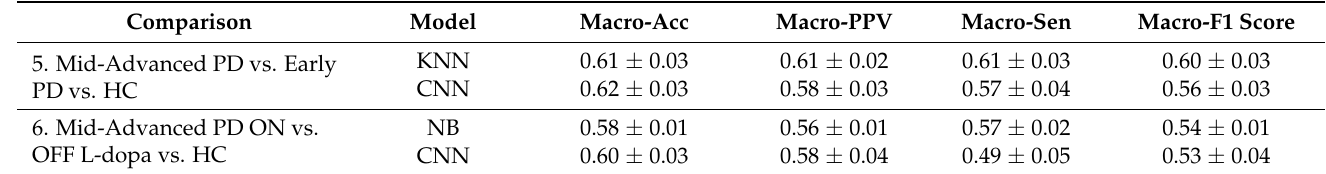
Table 7. Multiclass classification performance of the best traditional ML and CNN models. Results are reported in terms of CV accuracy. Acc: accuracy; PPV: positive predictive value; NPV: negative predictive value; Sen: sensitivity; Spec: specificity; AUC: area under the curve.